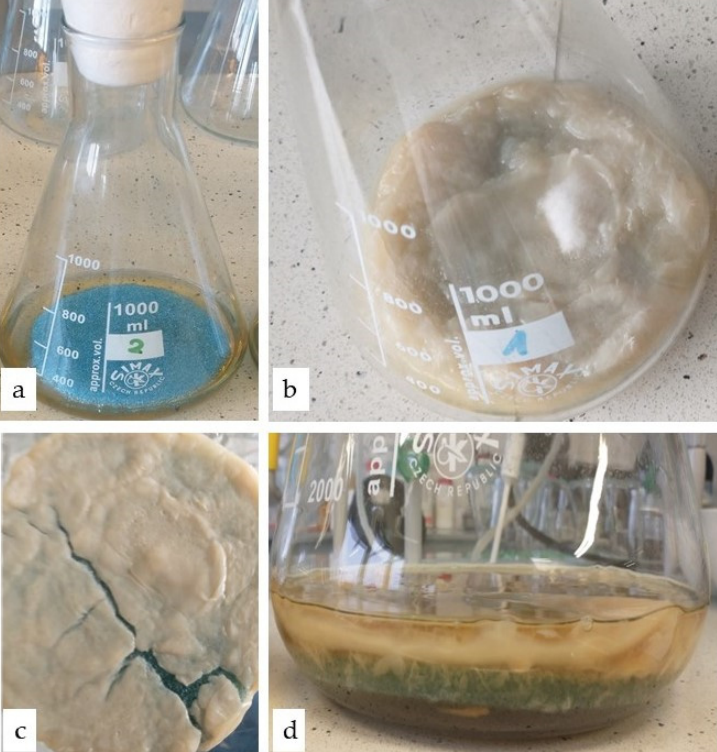
Figure 1. Immobilization of B. adusta DSM 3375 mycelium in PUF: ( a ) FiltrenTM30 foam placed in the medium, photo taken before starting the cultivation; effect of immobilization of mycelium in foam: ( b , c ) shake culture, ( d ) stationary culture.